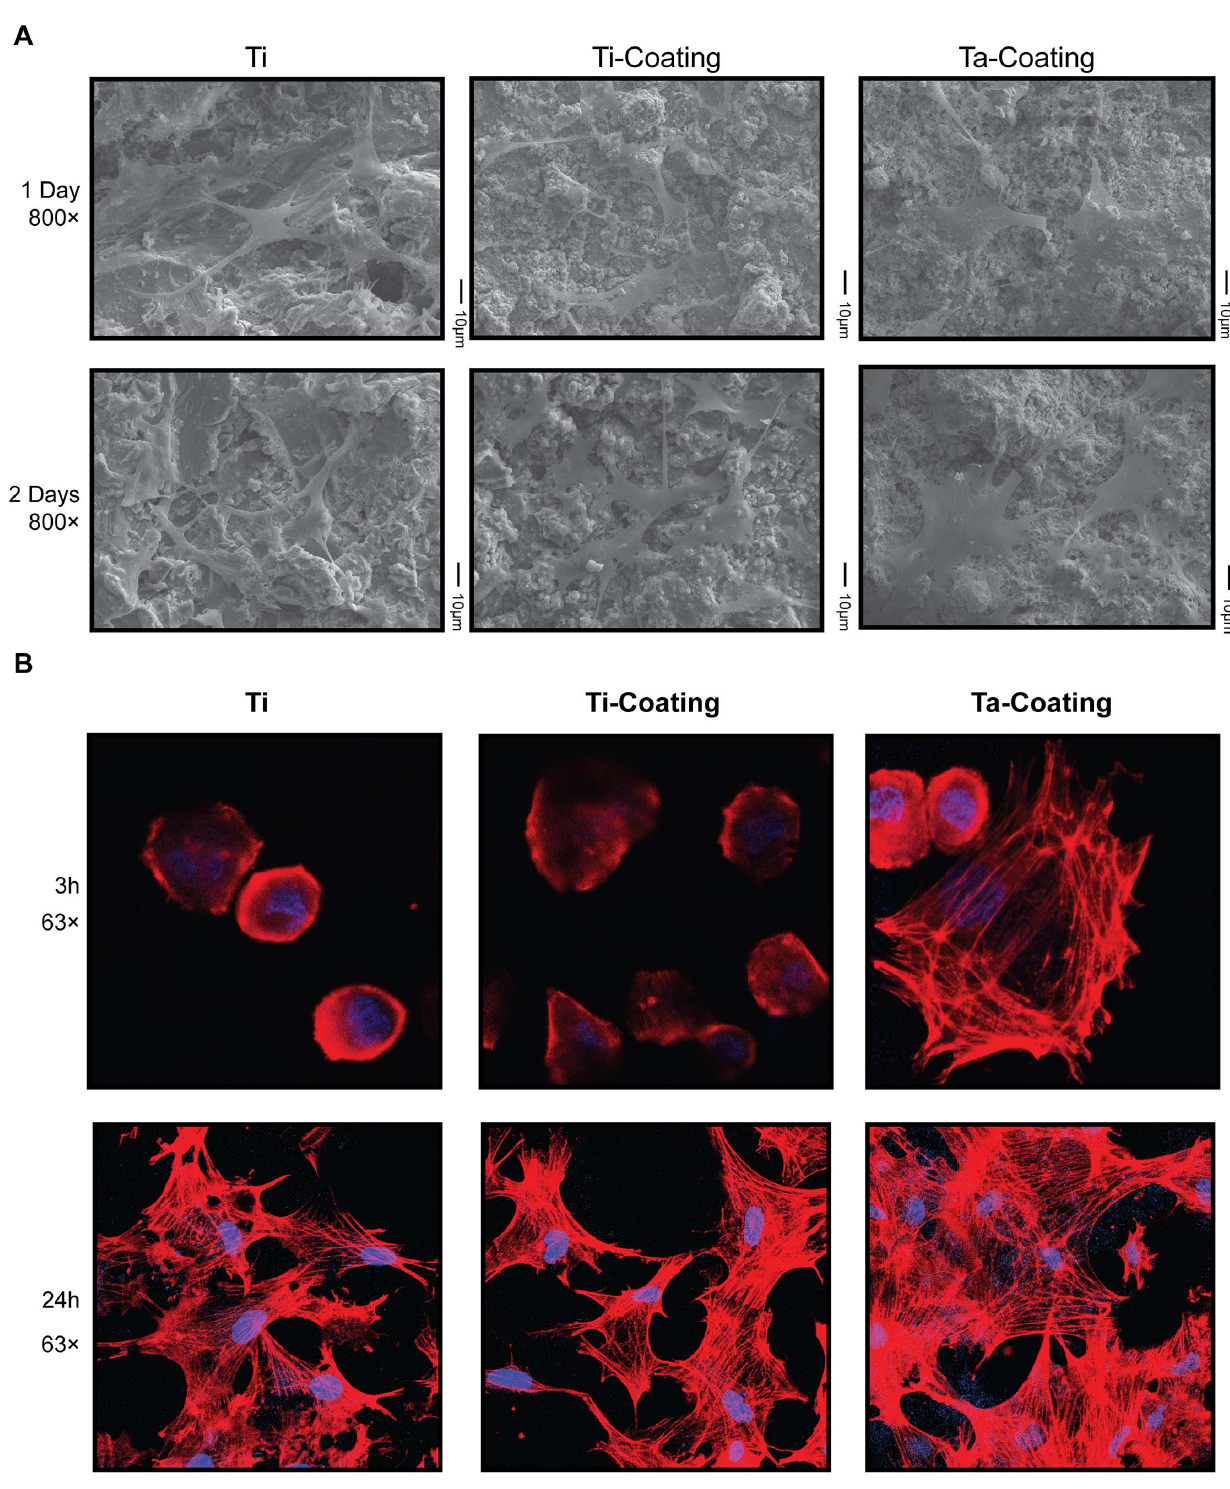
Figure 3. Morphology of hBMSCs cultured on Ta and Ti coatings. ( A ) SEM images of the surface morphology of both coatings with cultured hBMSCs at 800 6 magnifications. ( B ) Confocal laser scanning microscopy images of single hBMSC F-actin cytoskeletal morphology on both coatings for 3 and 24 h. (red, phalloidin for F-actin; blue, DAPI for nucleus). doi:10.1371/journal.pone.0066263.g003 osteogenetic differentiation evaluation. Rabbit femur implant formation ability of porous Ta coating in vivo. This would be of models were used to evaluate the osseointegration and new bone